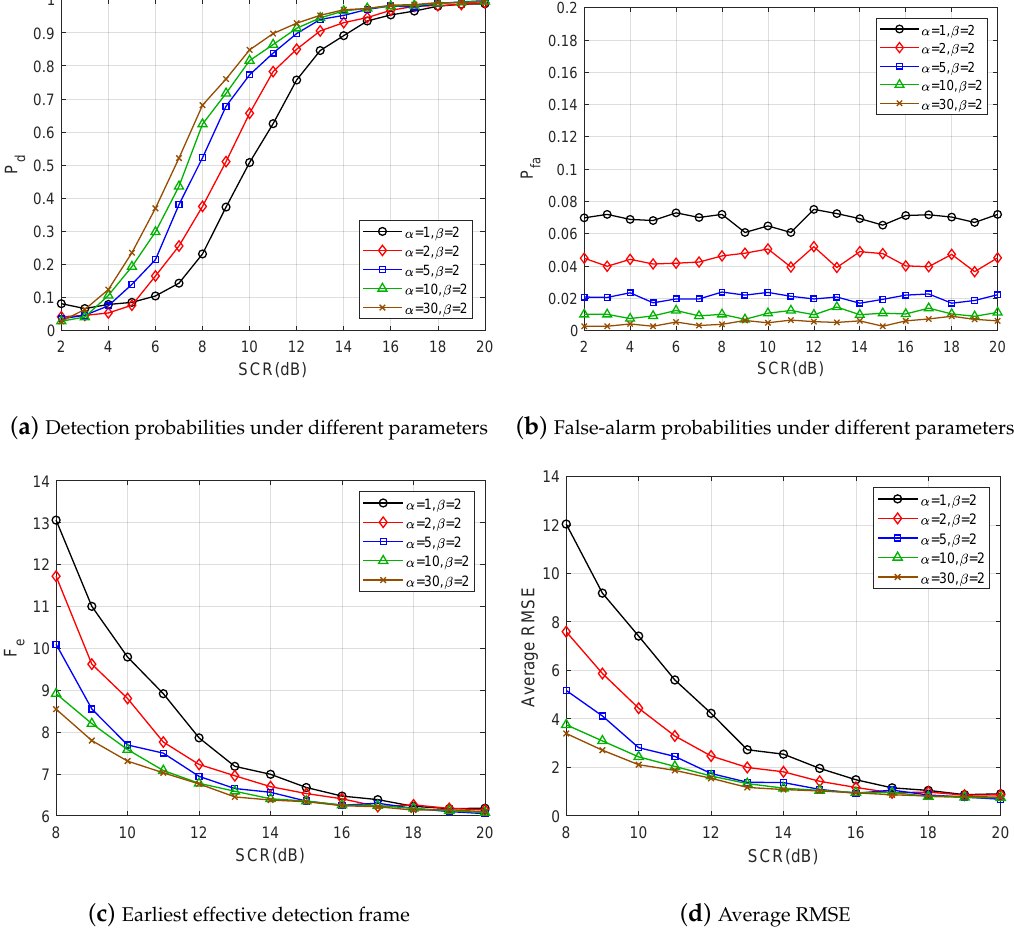
Figure 8. Performances under different K-distribution